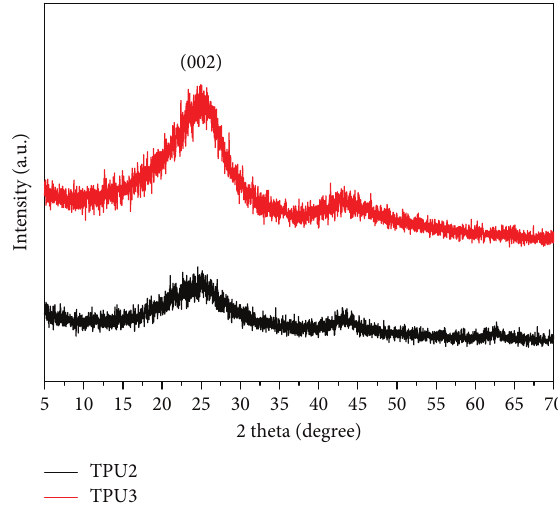
Figure 9: XRD patterns of char residues of TPU2 and TPU3